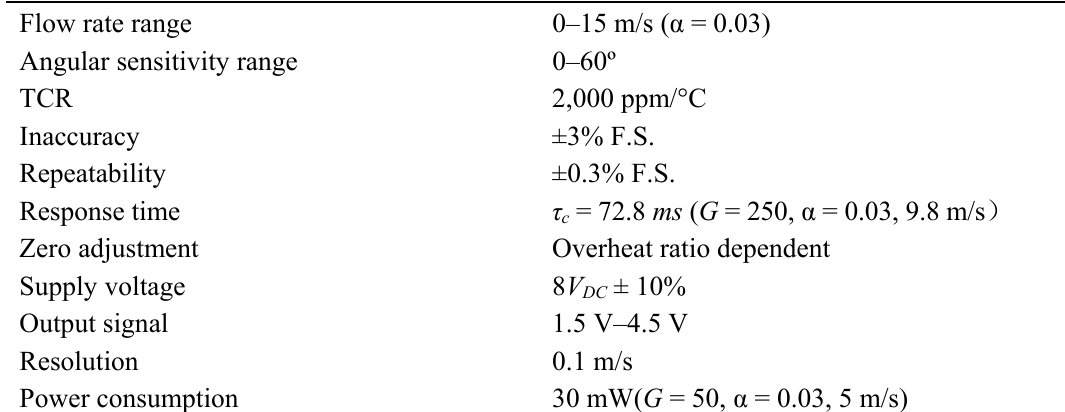
Table 2. The performances of the flow sensor